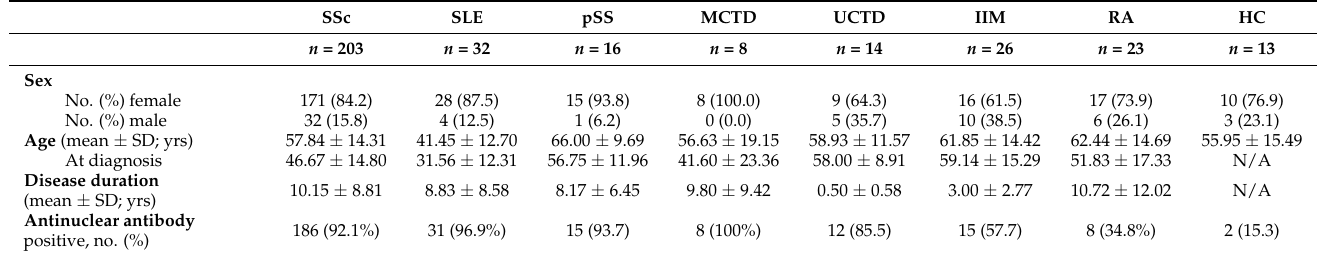
Table 1. Demographic characteristics.